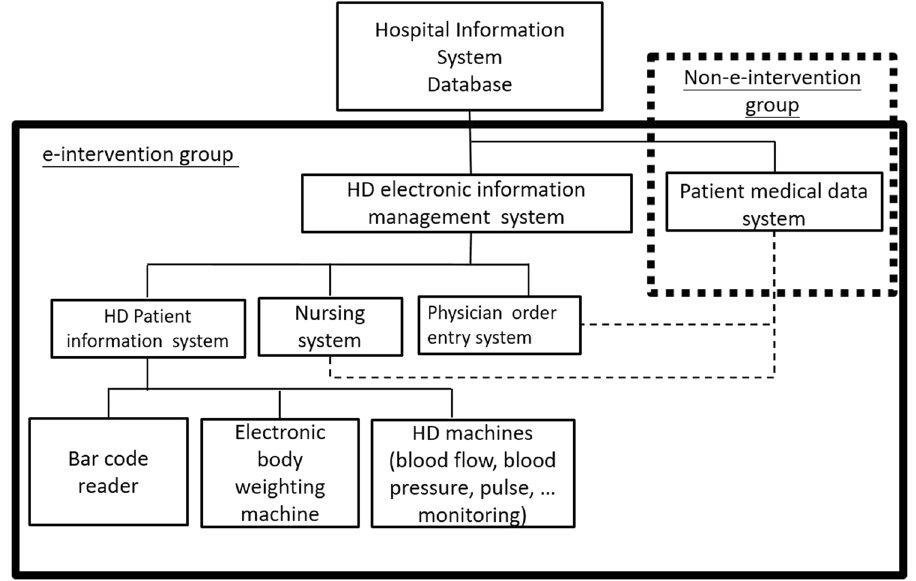
Figure 3. The architecture of the information systems utilized in this